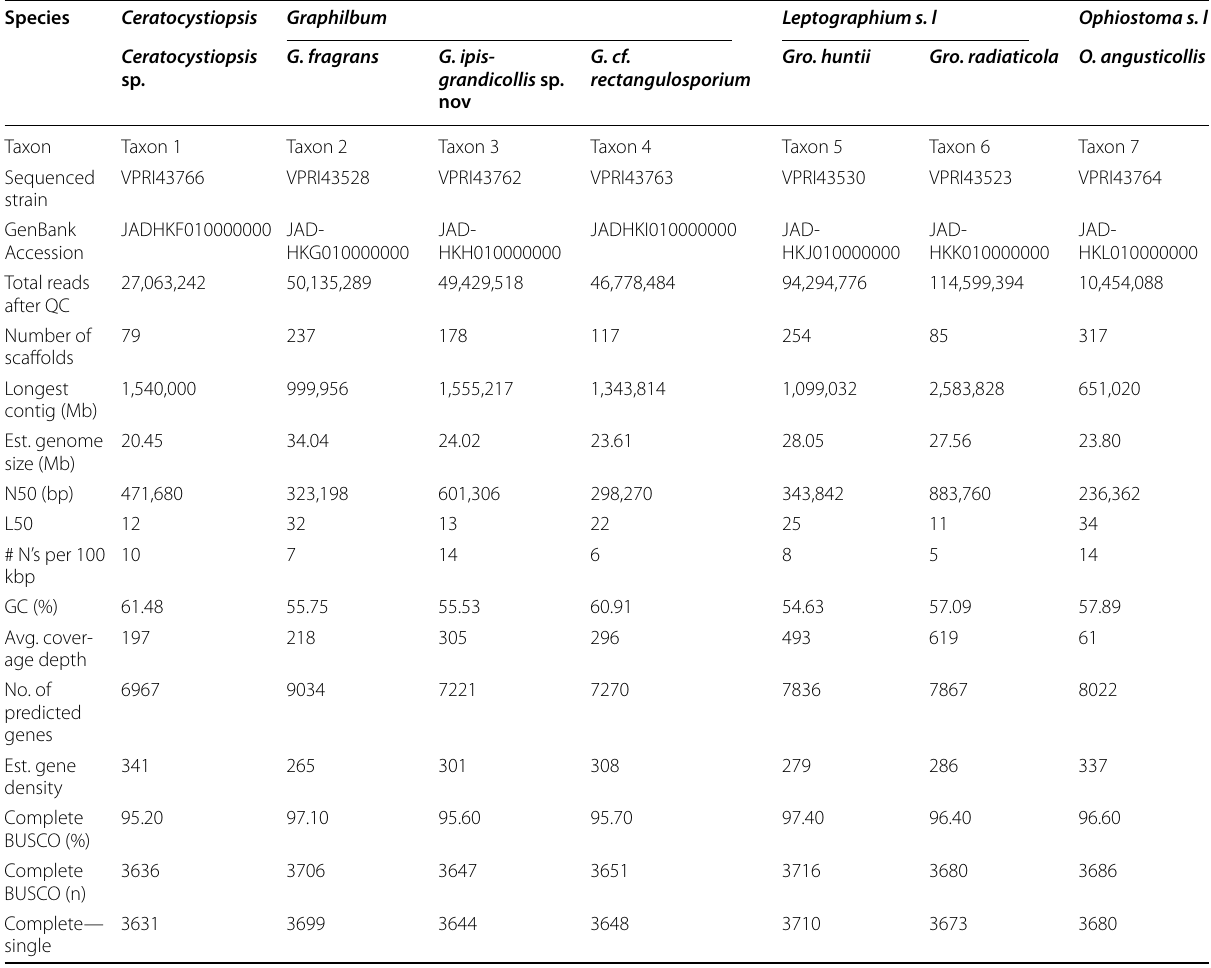
Table 3 Genome summary statistics of representative ophiostomatoid isolates sequenced in this study Species